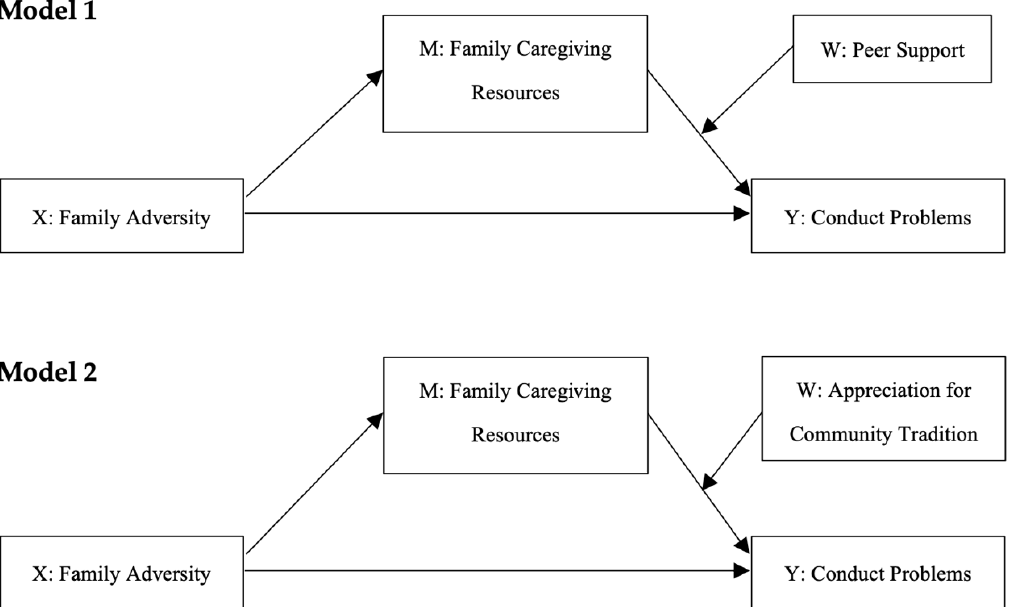
Figure 1. Conceptual models representing the two moderated mediation models tested in the study.